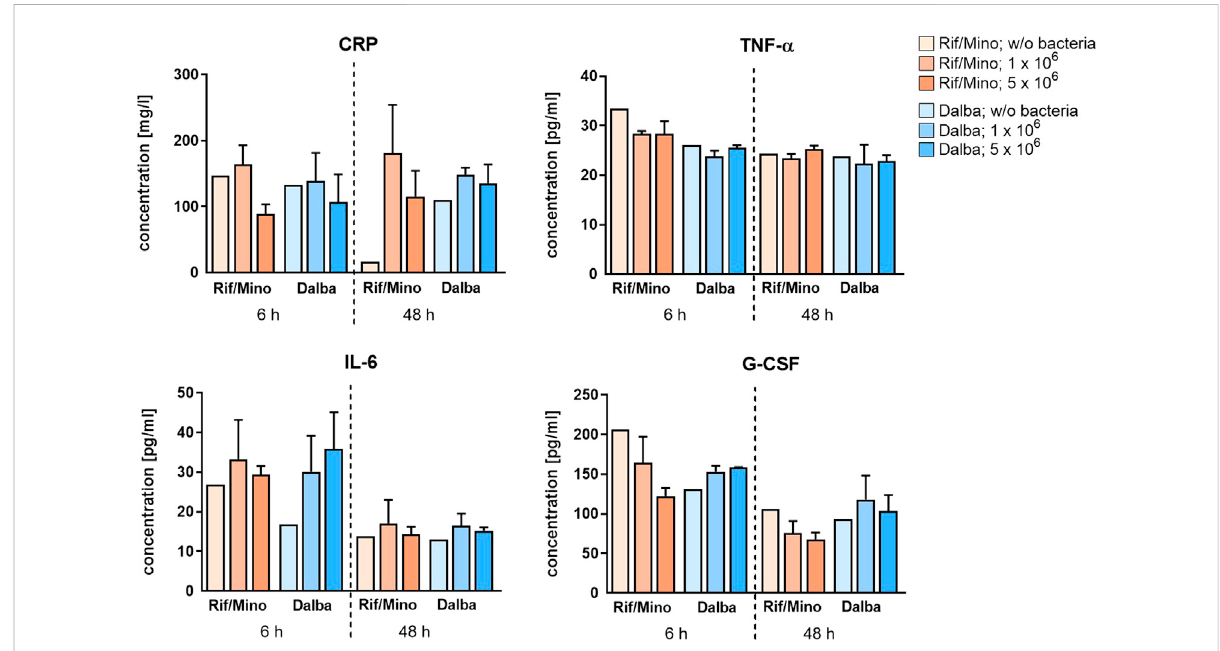
FIGURE 4 Antibiotic coatings reduce the bacteria-induced systemic immune response in the host. The concentration of cytokines (CRP, TNF- α , IL-6 and G-CSF)inpooledbloodplasmawasquanti fi edusingELISAafter6and48 h.ForCRPdetection,sampleswerediluted1:10 6 inrecommendedreaction buffer. Data are represented as mean + SD. Rif/Mino: rifampicine/minocycline; Dalba: